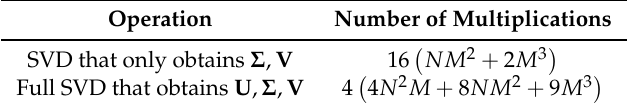
Table 2. Computational complexity for SVD operation of an M × N complex